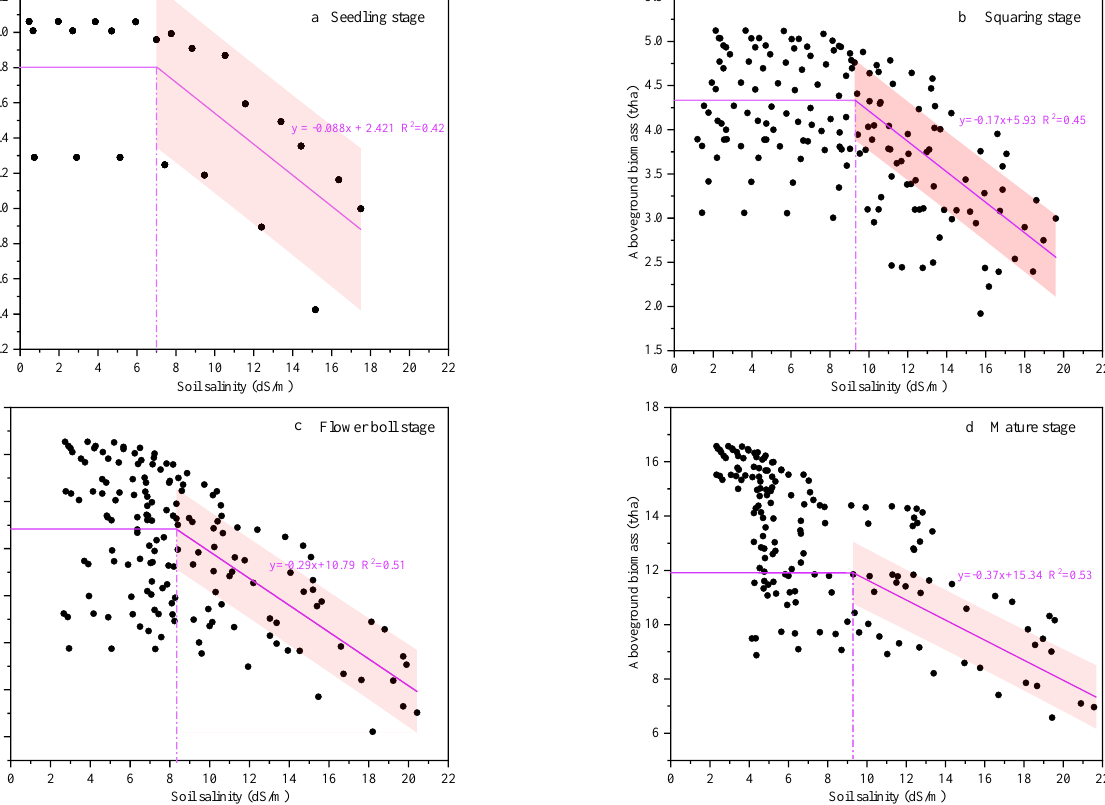
Figure 14. Relationship between the aboveground biomass and the soil salinity (ECe) at different growth stages of cotton. (a, b, c and d represent the different growth stages, respectively.)